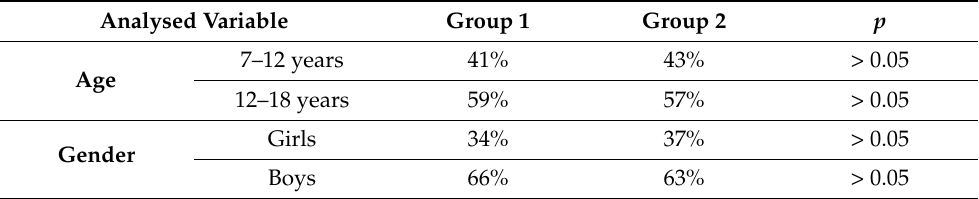
Table 1. Demographic data of the studied ADHD